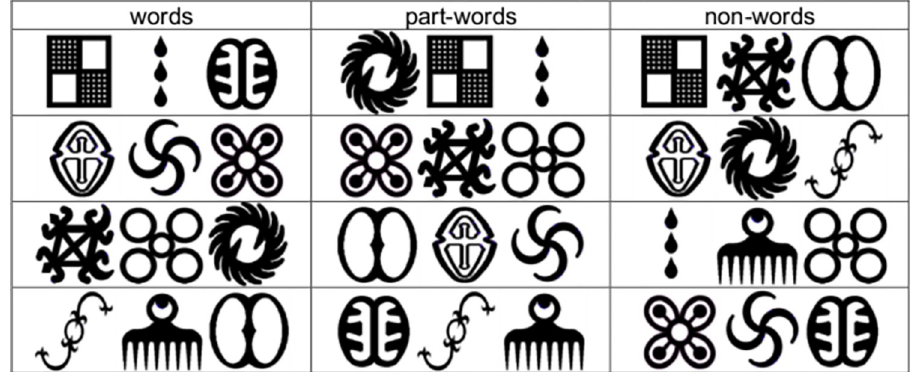
Fig 2. Stimuli in the nonverbal visual